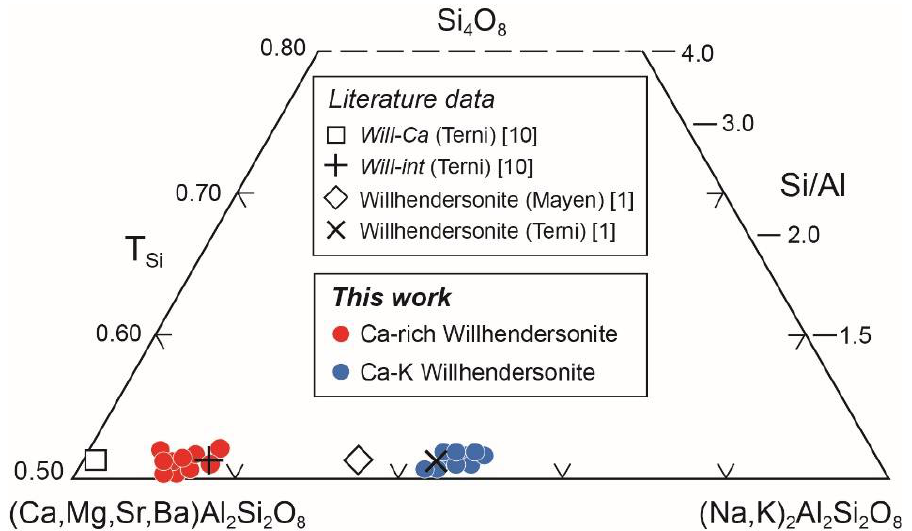
Figure 4. Compositional ternary diagram illustrating major variations of willhendersonite compositions. Red and blue circles are crystals from the Lessini Mounts. Components are: S 4 O 8 (molecular proportions [Si − 2(Ca + Mg + Sr + Ba) − 2(Na + K)]/4, (Ca,Mg,Sr,Ba)Al 2 Si 2 O 8 (molecular proportions Ca + Mg + Sr + Ba), and (Na,K) 2 Al 2 Si 2 O 8 (molecular proportions (Na + K)/2).